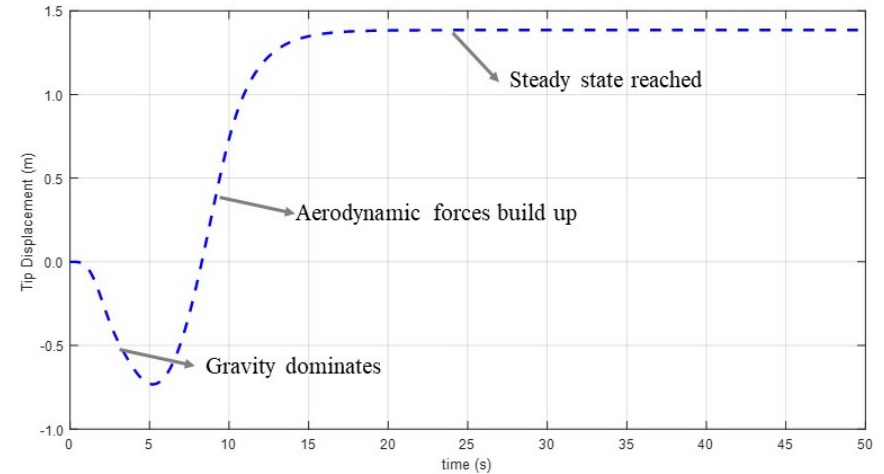
Figure 6. Tip response of wing without separation.